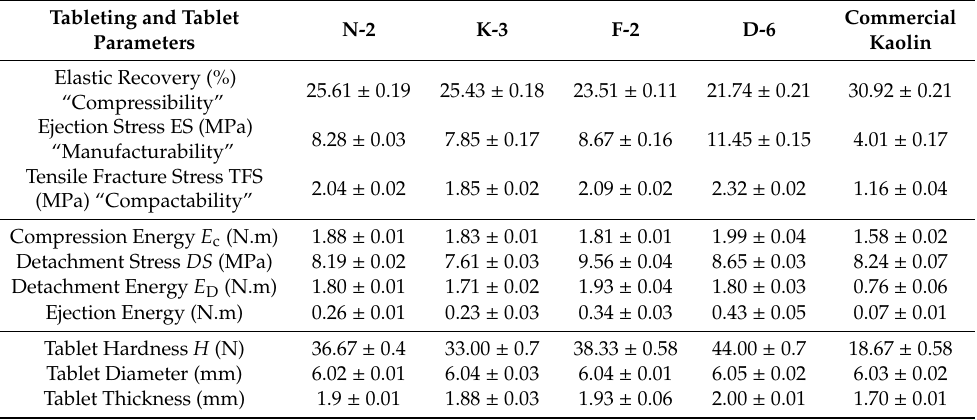
Table 4. Tableting parameters estimated to each seven tablets manufactured from the four representative kaolin powder